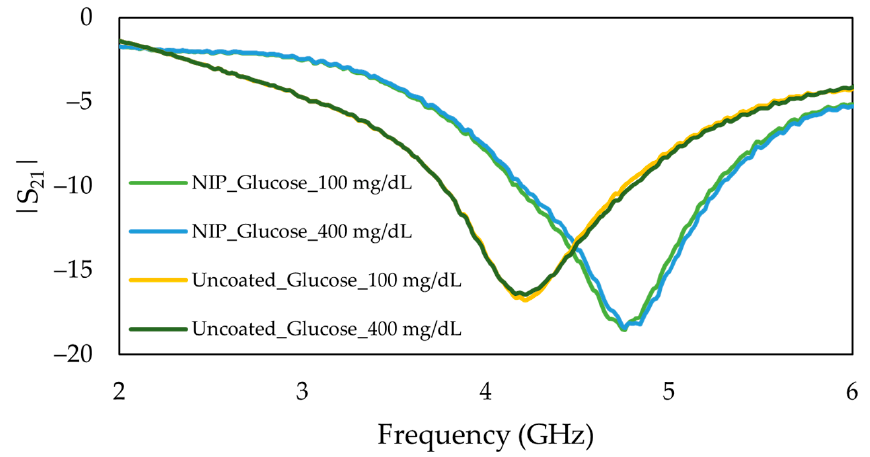
Figure 13. Frequency response of uncoated and NIP-coated microwave-based stub biosensor for the same glucose solutions of 100 mg/dL and 400mg/dL.